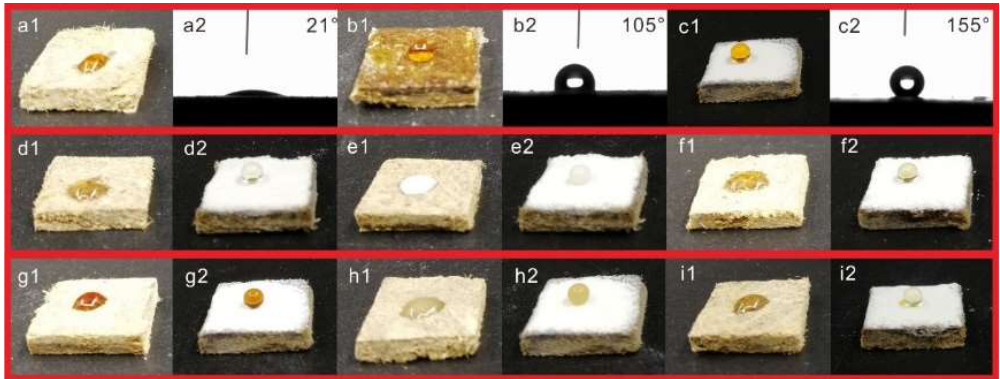
Figure 5. Digital photos and contact angle images of water on different surfaces: ( a ) MDFs; ( b ) MDFs coated with PDMS; ( c ) MDFs coated with PDMS@FDTS-Mg/Al LDH; Images of different liquids on the surface of MDFs ( d1 – i1 ) and MDFs coated with PDMS@ FDTS-Mg/Al LDH ( d2 – i2 ): ( d ) tea; ( e ) milk; ( f ) cola; ( g ) soy sauce; ( h ) coffee; ( i ) orange juice.